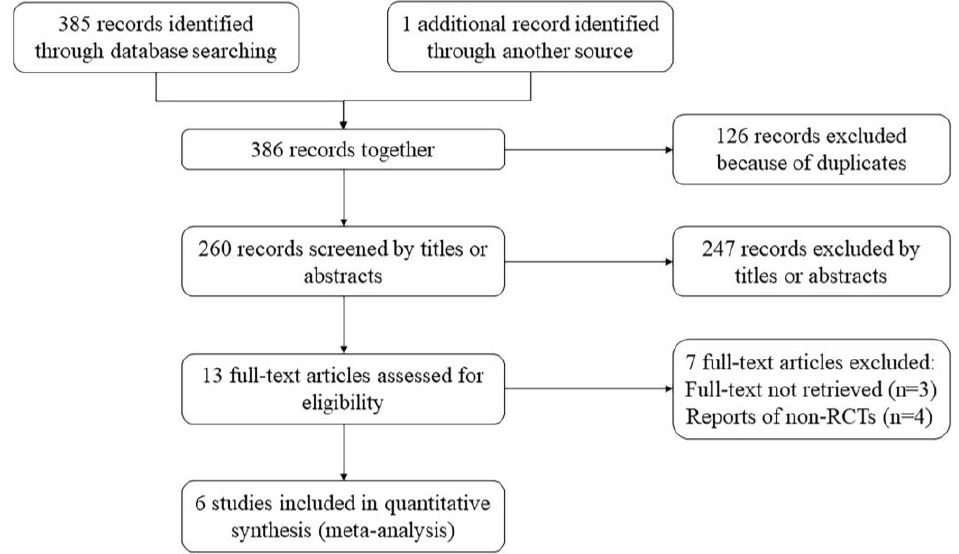
Figure 2. Flow chart of the study included in this systematic review.